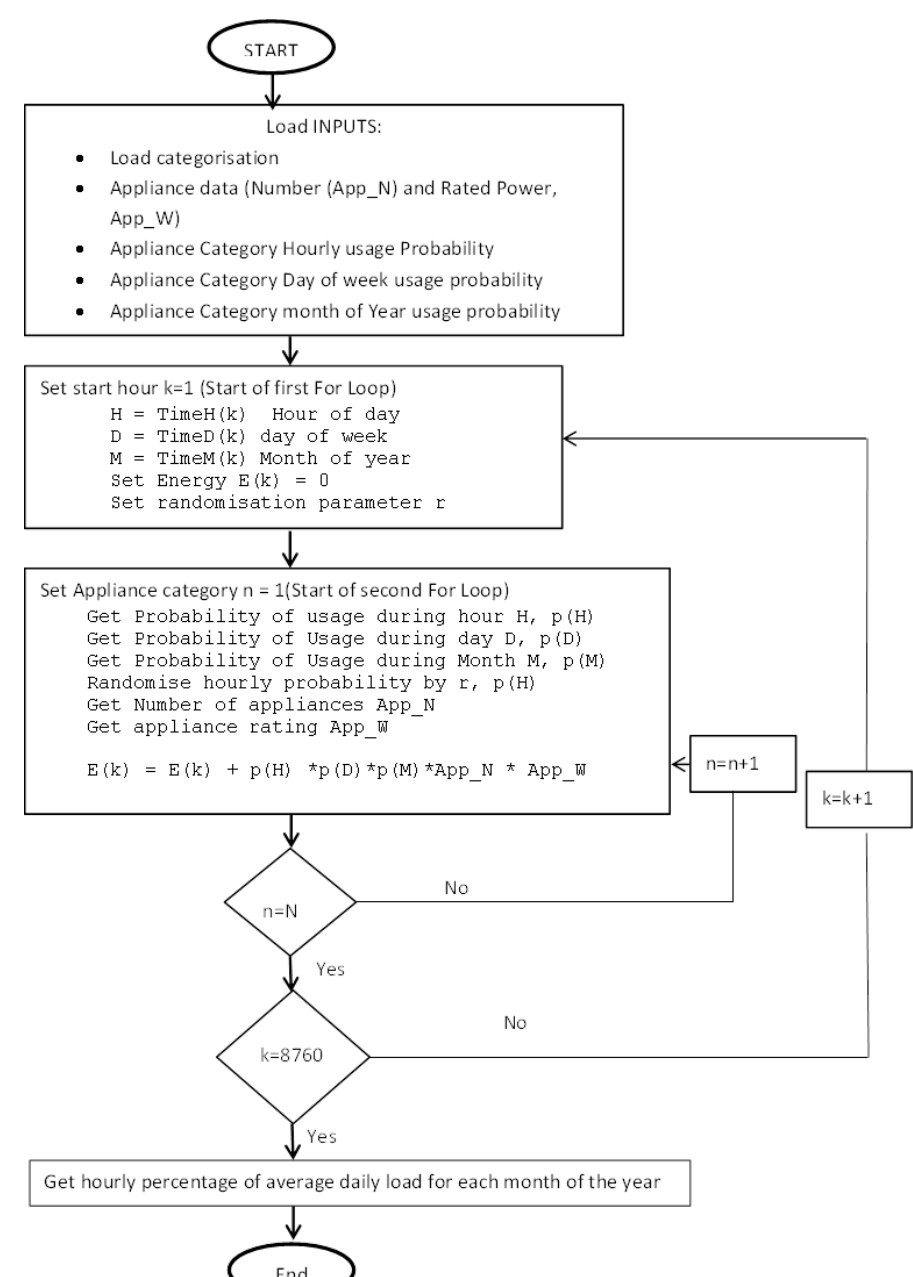
Figure 2. Flow chart for calculation of hourly percentage of daily load.